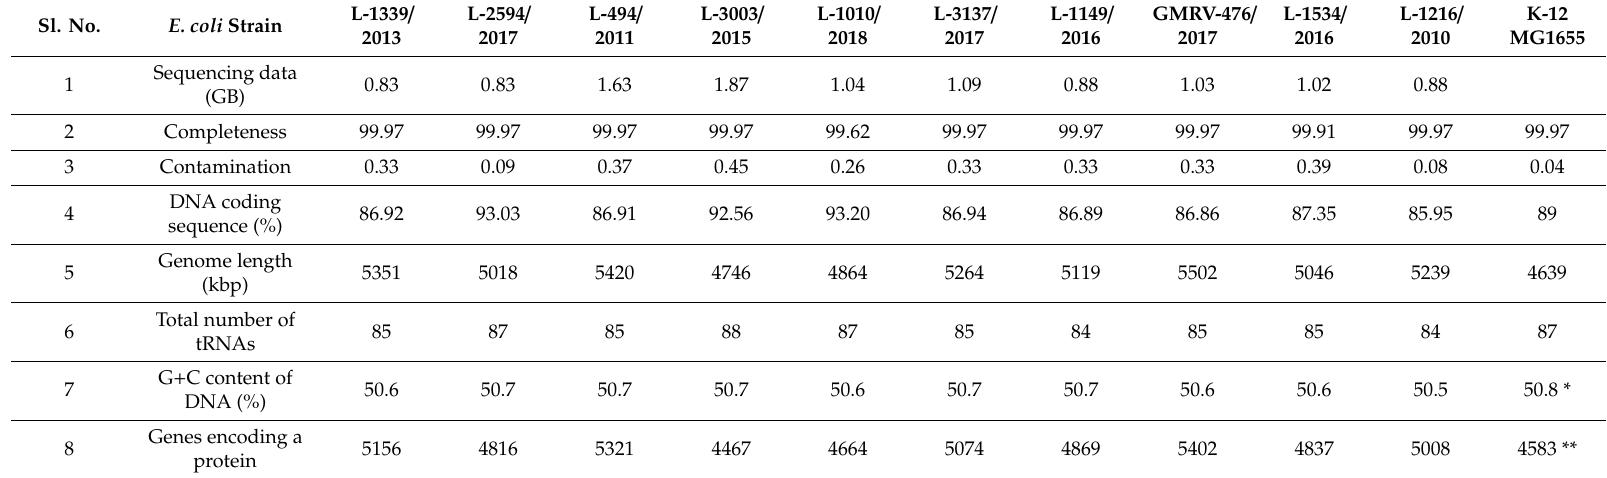
Table 1. Characteristics of the whole-genome sequences of the 10 ocular Escherichia coli isolates. Sl.